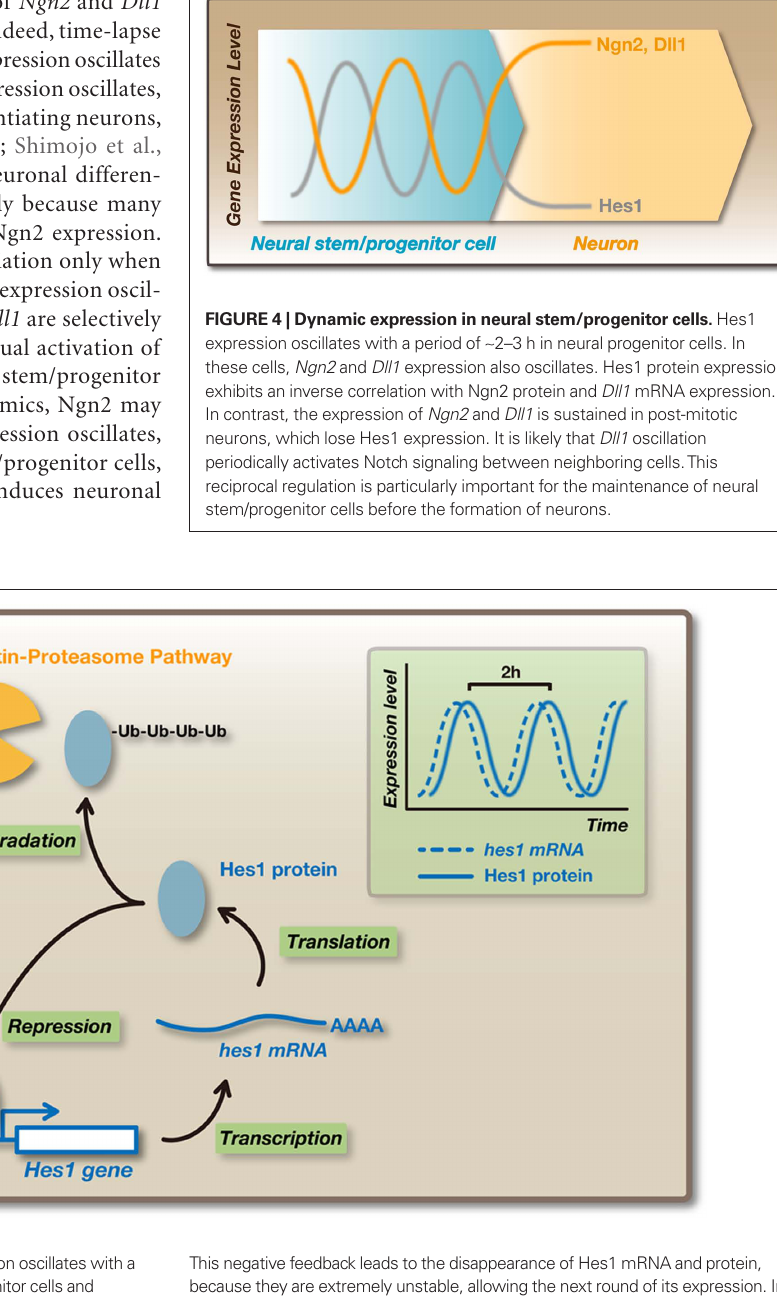
This negative feedback leads to the disappearance of Hes1 mRNA and protein, because they are extremely unstable, allowing the next round of its expression. In this way, Hes1 autonomously starts an oscillatory expression